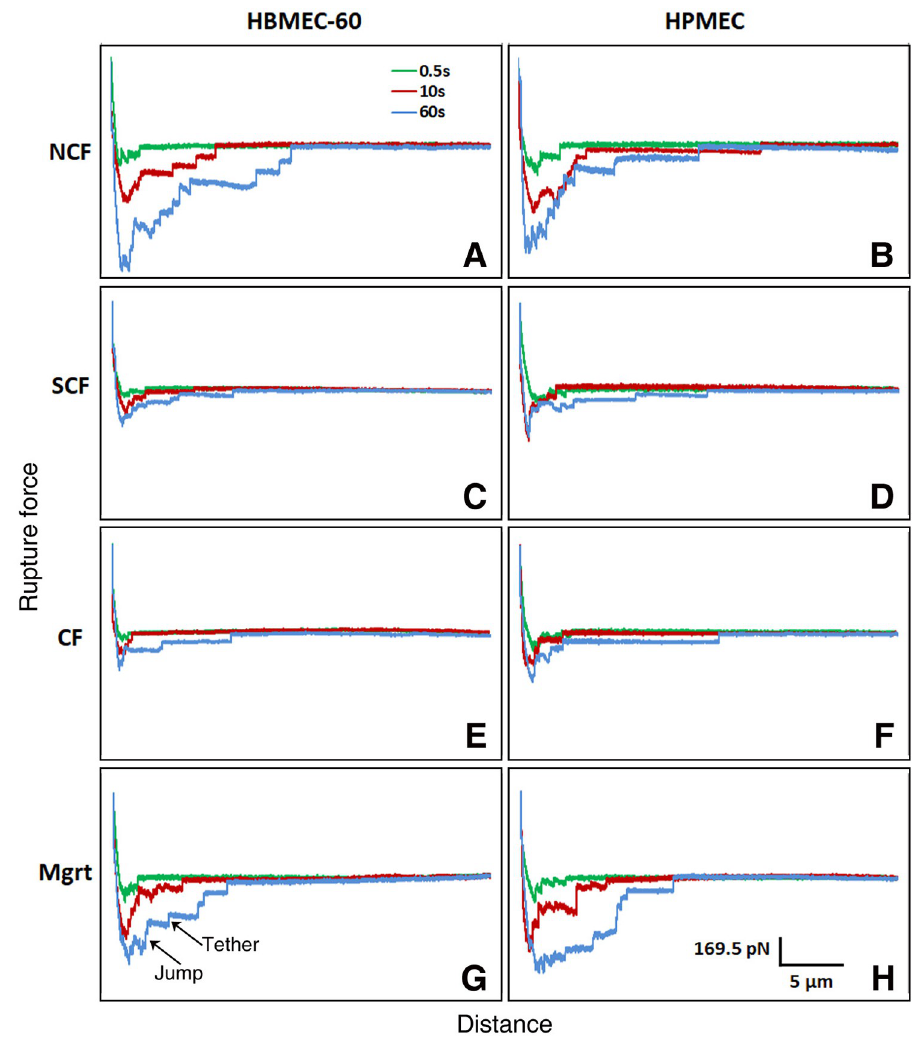
Fig 9. Typical AFM detachment curves of MB231 cells interacting with HBMEC-60 (A, C, E and G) and HPMEC (B, D, F and H) cells at NCF (A and B), SCF (C and D), CF (E and F) and Mgrt (G and H) states for 0.5 (green), 10 (red) and 60 (blue) sec cell contact times. For both HBMEC-60 and HPMEC note significant increase in overall adhesion force between MB231 and ECs in NCF and Mgrt states compared to SCF and CF cells most noticeable for 10 and 60 sec cell contact times and accompanied by obvious increase in the number of both jumps and tethers (indicated with arrows in G) suggesting the involvement of both, receptors that are tightly associated (jumps) and weakly or not associated (tethers) with the cytoskeleton. Scale for Y and X axes are shown in